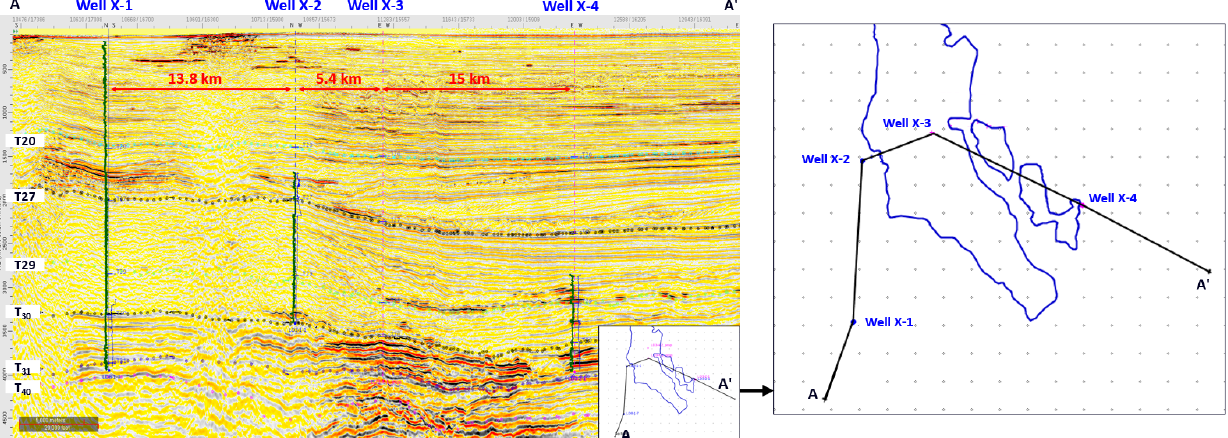
Figure 2. Well trajectory on section A of well block X.